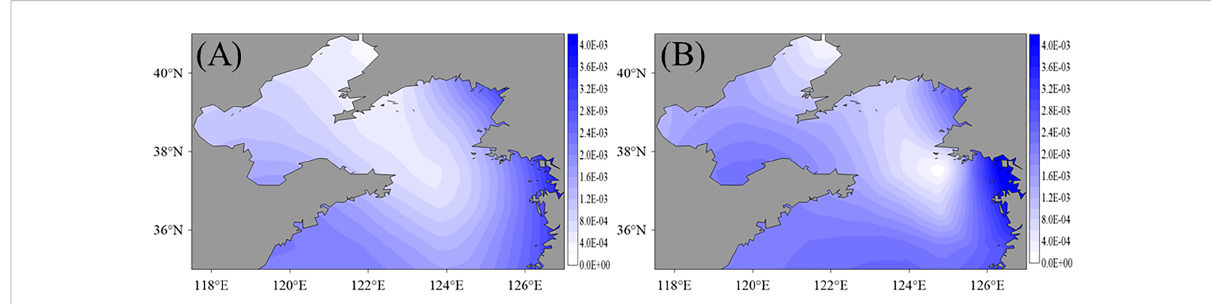
FIGURE 9 The BFC distributions after data assimilation with the same 35 IPs, 1/12°×1/12° observational grids but with Cressman parameter 2.5° (A) in EXP 6 and 1.5° (B) EXP